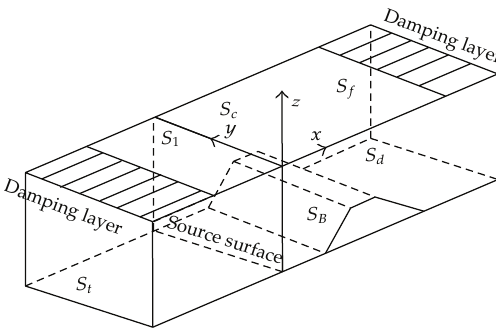
Figure 1: Sketch of the numerical wave tank